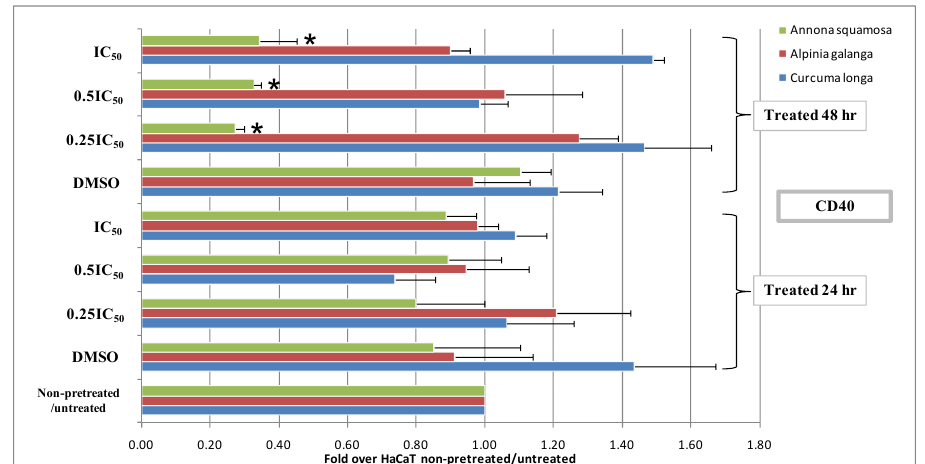
(A) Representative 2% agarose gel electrophoresis of RT-PCR products showing corresponding mRNA transcripts of RelA, NF- κ B1, CD40 and β -actin after treatment for either 24 h or 48 h with 0.25 IC , 0.5 IC and IC of extracts from Annona squamosa leaves (IC 50 50 50